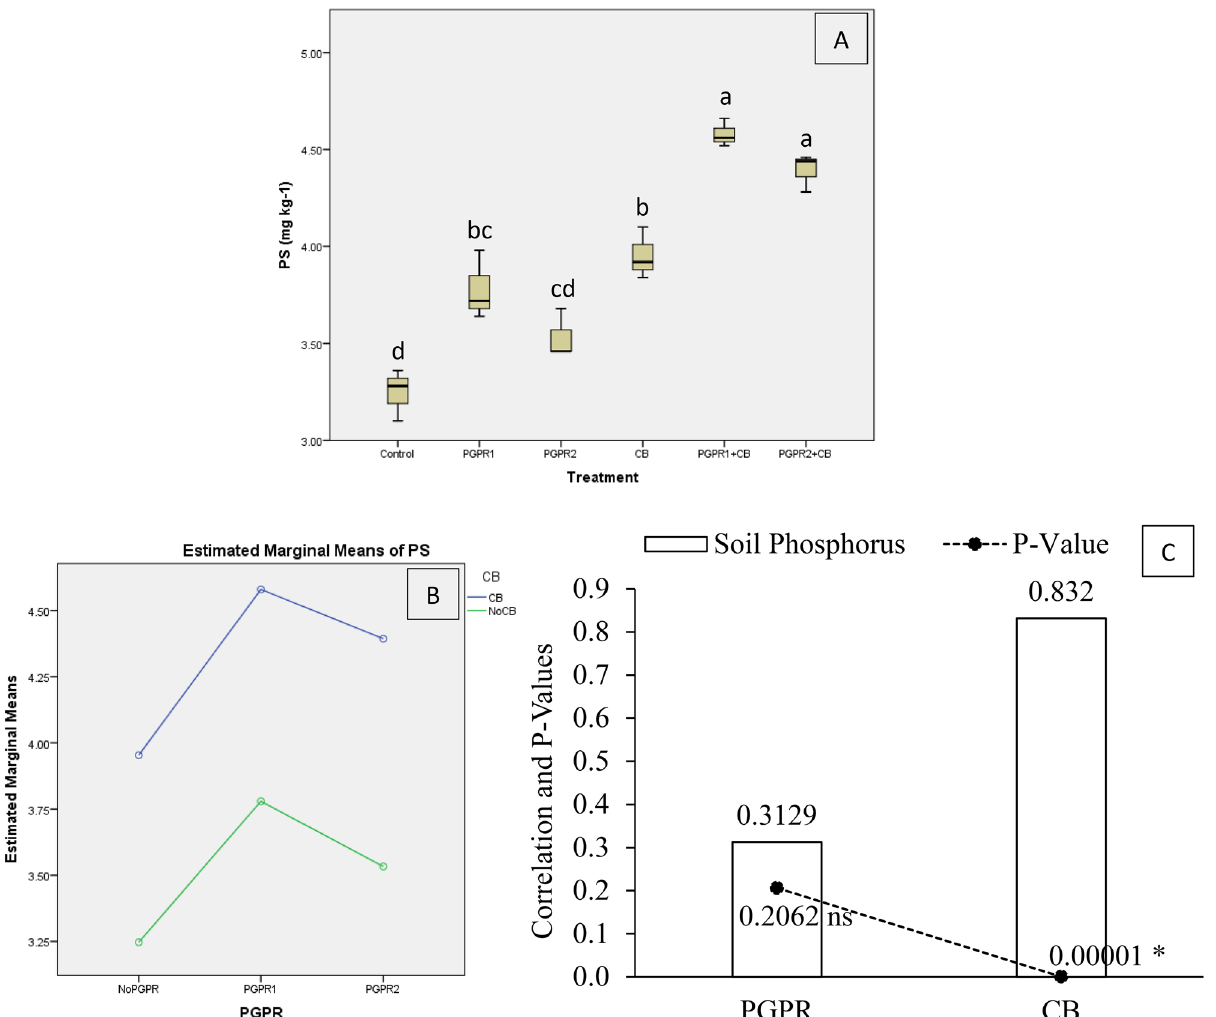
Figure 5. Effect of treatments on soil phosphorus (PS). Values are the average of three replicates ( A ). Different letters showed significant differences (Tukey’s test; p ≤ 0.05). Interaction graph of PGPR and CB for soil PS ( B ). Correlation graph of PGPR and CB for soil PS ( C